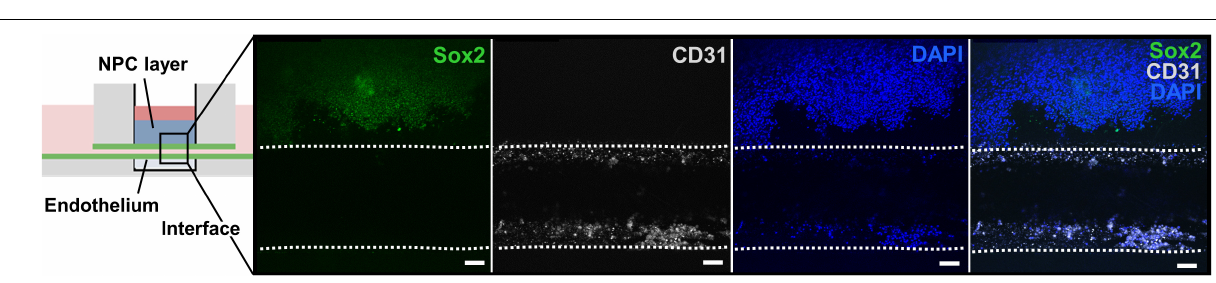
ex vivo tissue models (Li and Kumacheva, 2018).